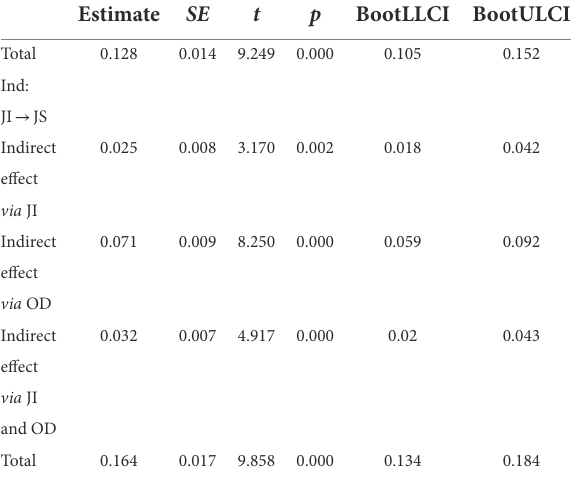
TABLE 4 Test of mediation of job insecurity and organizational identity on the relationship between positive workplace gossip and job satisfaction: Bootstrap